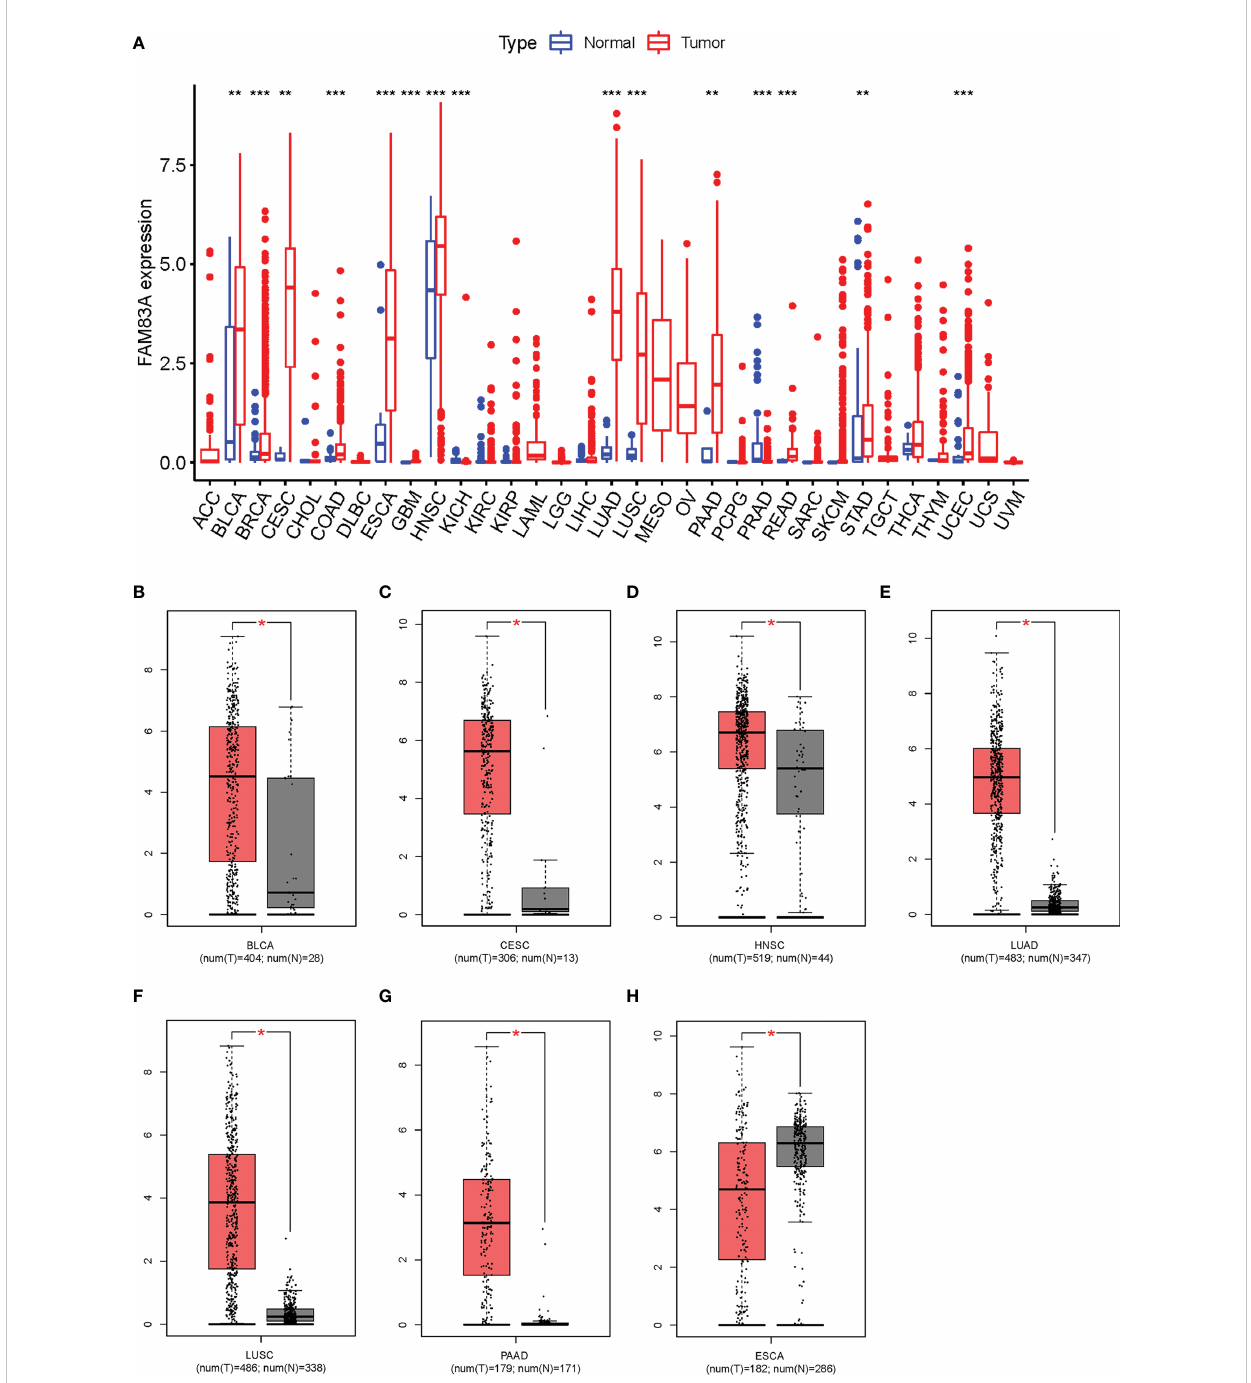
FIGURE 1 Expression analysis for FAM83A in multiple cancers: (A) The expression of FAM83A in human cancers based on TCGA database. (B – H) The differential expression of FAM83A between tumor and normal tissues in TCGA and GTEx: (B) BLCA (C) , CESC (D) , HNSC (E) , LUAD (F) , LUSC (G) , PAAD (H) , ESCA. *p value < 0.05; **p value < 0.01; ***p value <